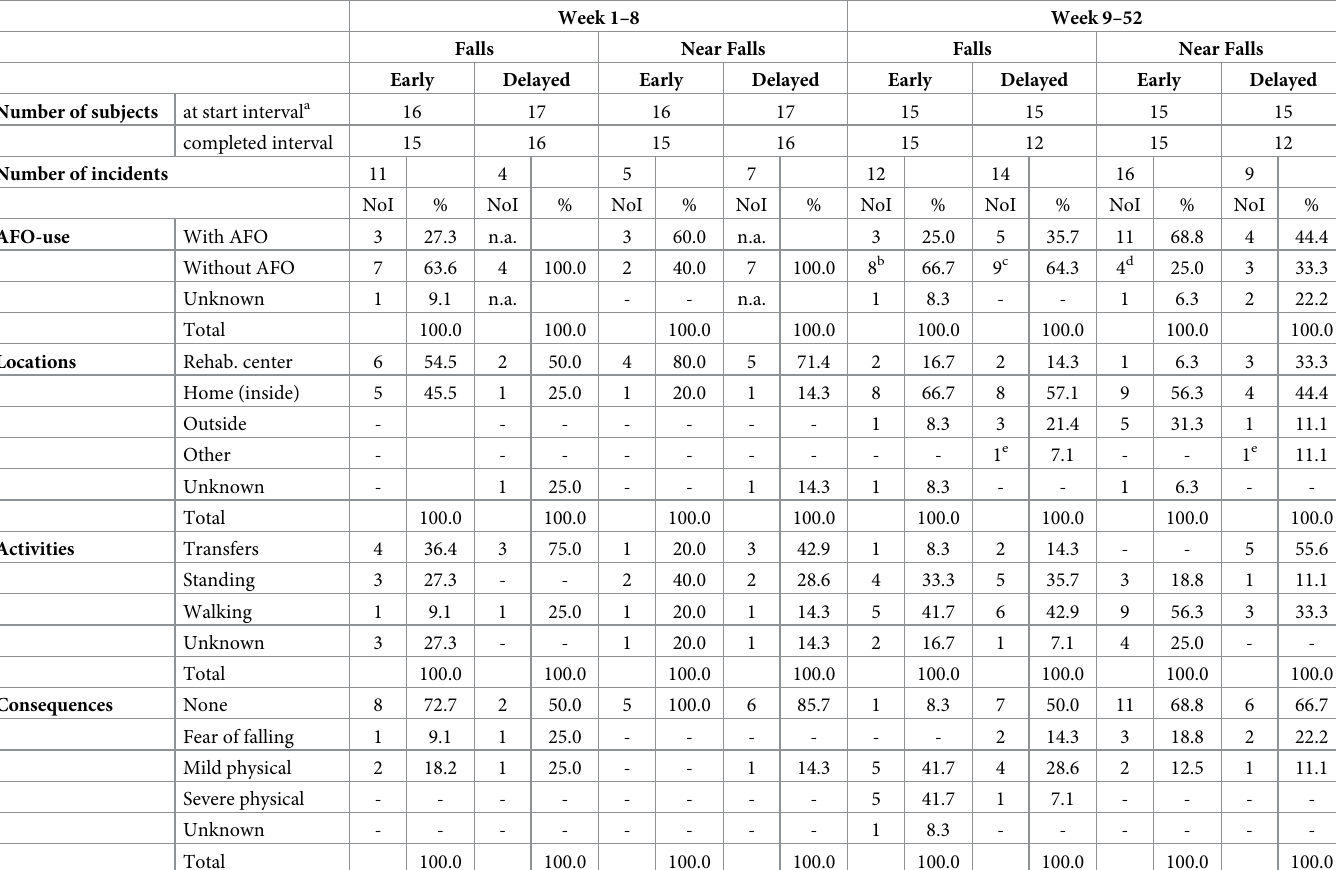
Table 4. AFO-conditions, locations, activities and consequences related to falls and near falls in week 1–8 and